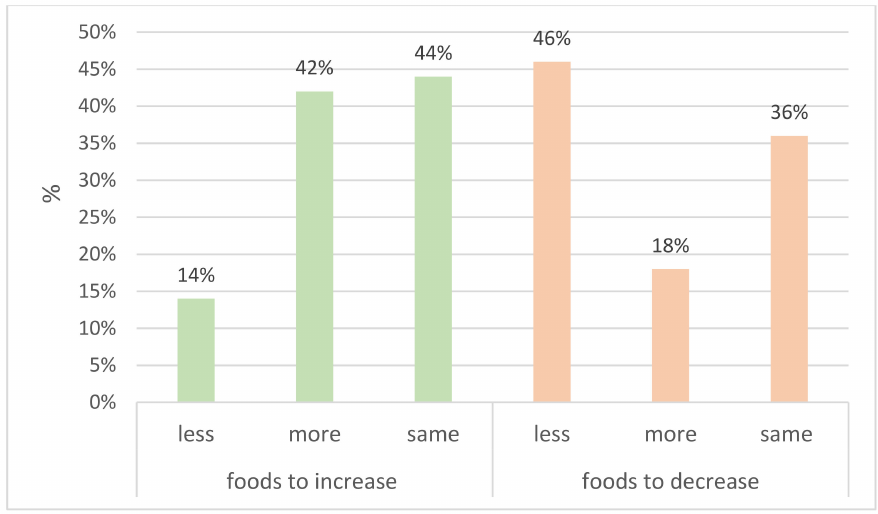
Figure 2. Changes in consumption per food category during lockdown compared to